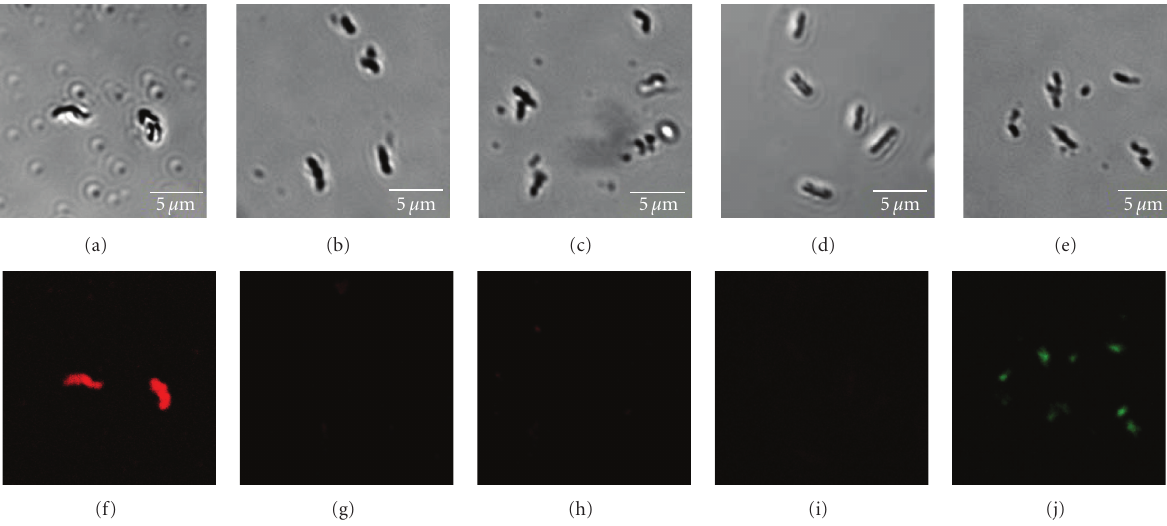
Figure 3: The specific, nonspecific interactions, and signal amplification e ff ect of biocojugated nanoparticles interacted with bacteria. All pictures were obtained with confocal microscopy (60 × oil), (a)–(e) transmission images, (f)–(j) fluorescence images. (a), (f) M. tuberculosis recognized with bioconjugated fluorescent nanoparticles. The bacteria display a bright fluorescence. (b), (g) Control with PBS in place of the primary rabbit anti- M. tuberculosis antibody. No fluorescence is associated with the bacteria. (c), (h) Control with rabbit anti-p53 antibody in place of the primary rabbit anti- M. tuberculosis antibody. No fluorescence is associated with the bacteria. (d), (i) E. coli incubated with bioconjugated fluorescent nanoparticles. No labeling of the bacteria with nanoparticle bioconjugates is observed. (e), (j) M. tuberculosis recognized with FITC conjugated rabbit anti- M. tuberculosis antibody. The bacteria display a faint